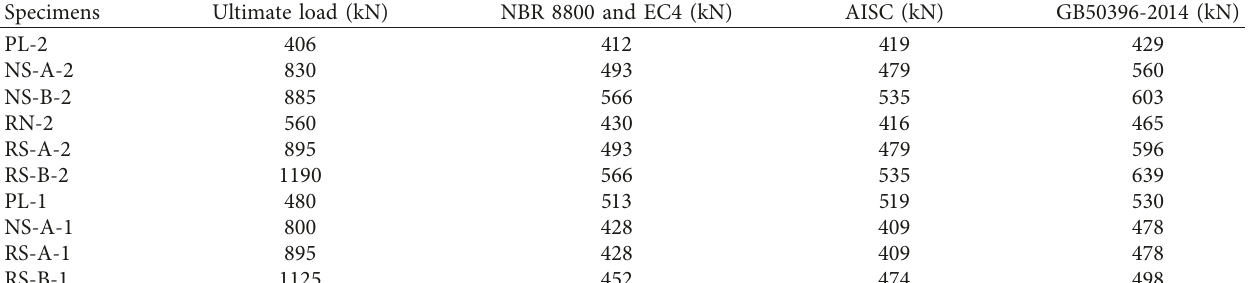
Figure 18: Relationship between n and load (n: ratio of rock-socketed depth, n Table 7: The ultimate strength calculation results of relevant specifications.